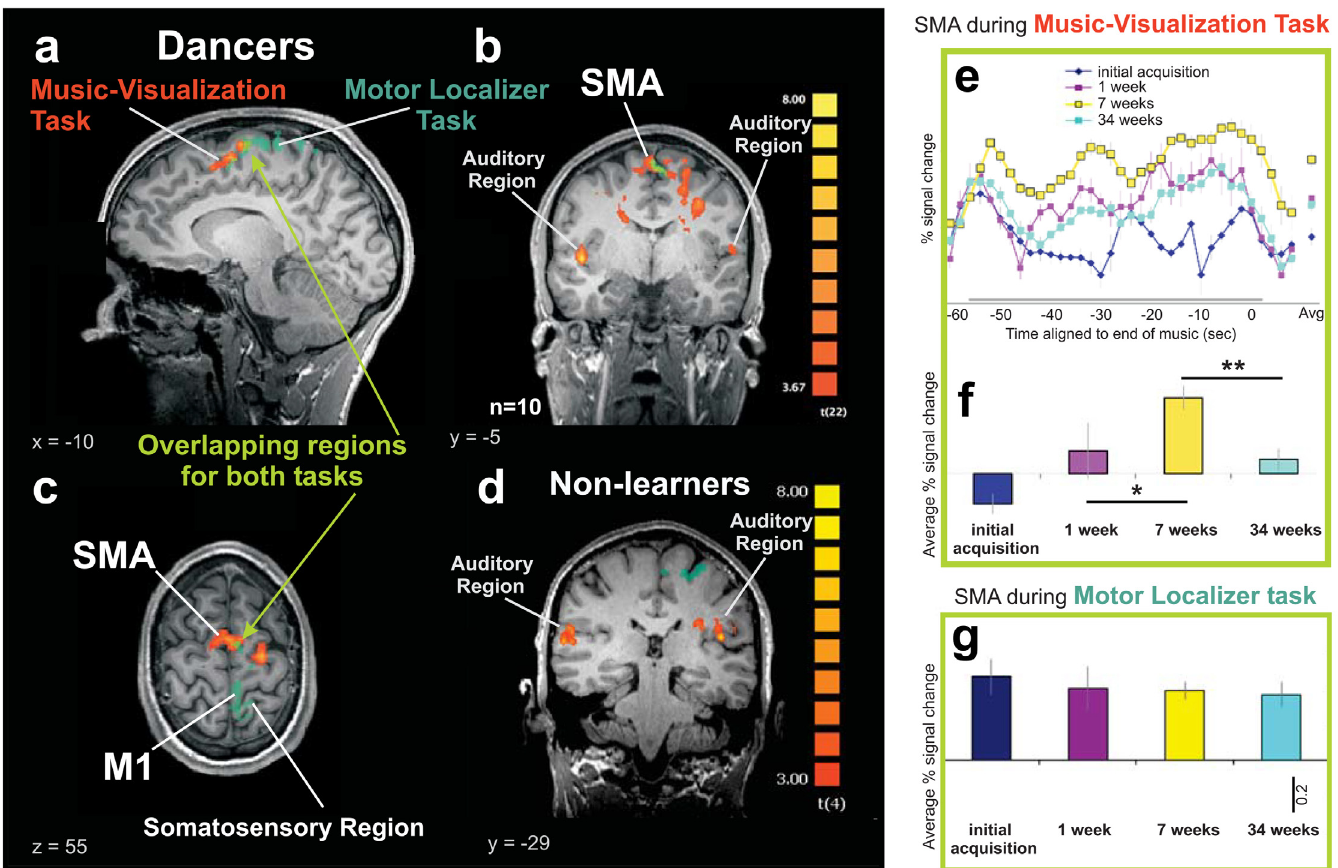
Fig 1. Supplementary motor area (SMA) in music-visualization and motor tasks. All figures show the average activity across participants. a-c, The overlapping region of interest (light green) was created with the GLM contrasts (music-visualization task > baseline) in orange and (motor task > baseline) in green, using a random effects general linear model (RFX GLM) from the third scan as described in the methods, p < 0.05, FDR corrected. The brain images have been made with a cluster threshold of 88 voxels (k > 88). d , Activity in our five control subjects matched for dance experience in the same two tasks as described in the methods above. No overlapping SMA region was found between the tasks in any slices – a representative slice shown here. e, Music- visualization task: percent of BOLD signal change extracted from the SMA (overlapping region) of all dancers at p < 0.05, FDR corrected. f , Music- visualization task: Average BOLD signals of each of the four scans in SMA region (taken from the gray period highlighted at the bottom of 1e and the averaged points in 1e). Signal increased from second to third scan ( p < 0.05, paired t -test) and decreased from third to fourth scan ( p < 0.05, paired t -test). g , Motor task: Average BOLD signal of the four scans in same SMA voxels. No significant changes were found across the scans in this task. All error bars represent the standard error of the mean (s.e.m.). Scale bar represents 0.2 percentage BOLD signal change. * signifies p < 0.07 trend and ** signifies p < 0.05 corrected for Bonferroni multiple